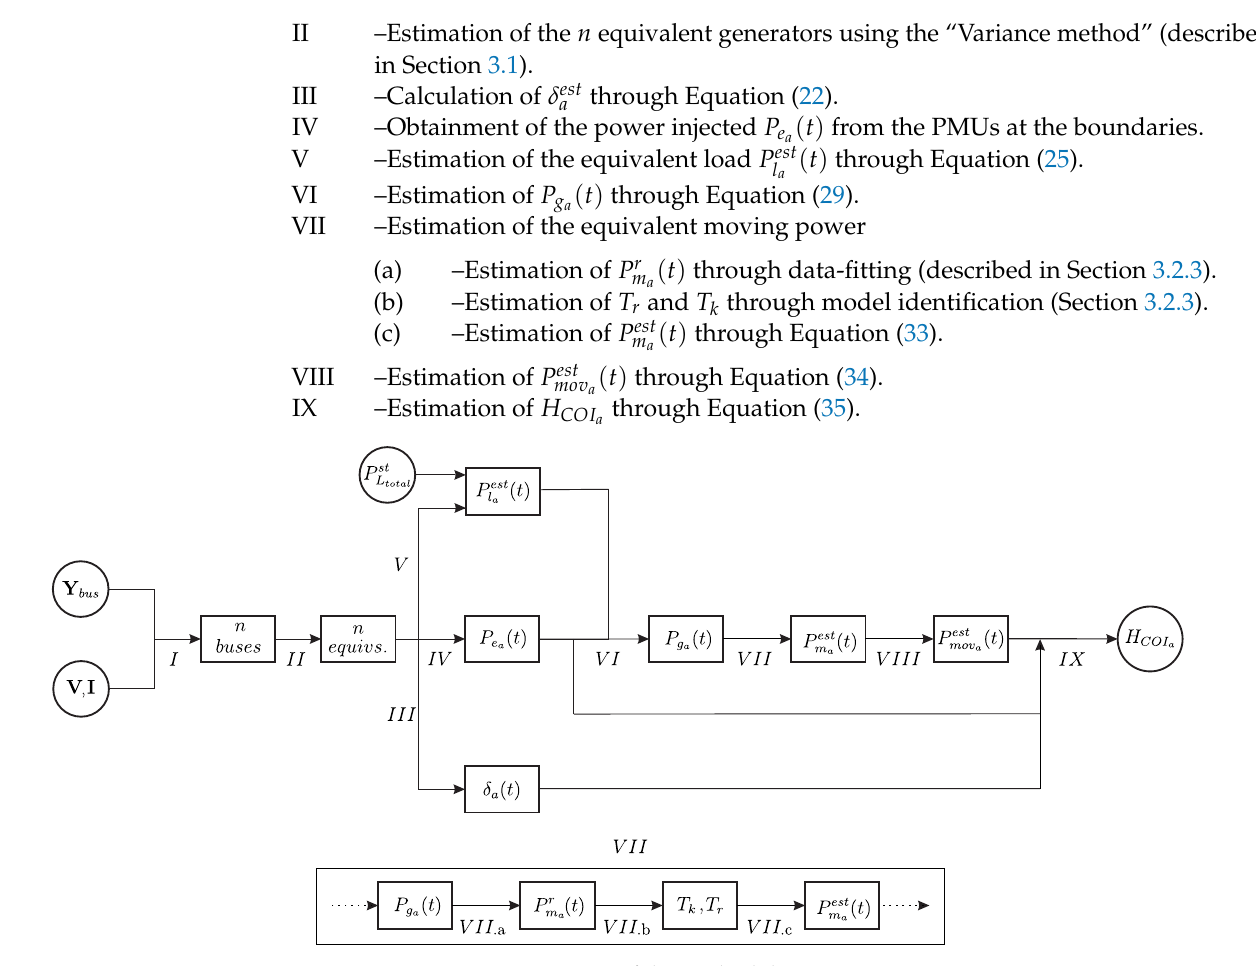
Figure 6. Summary of the